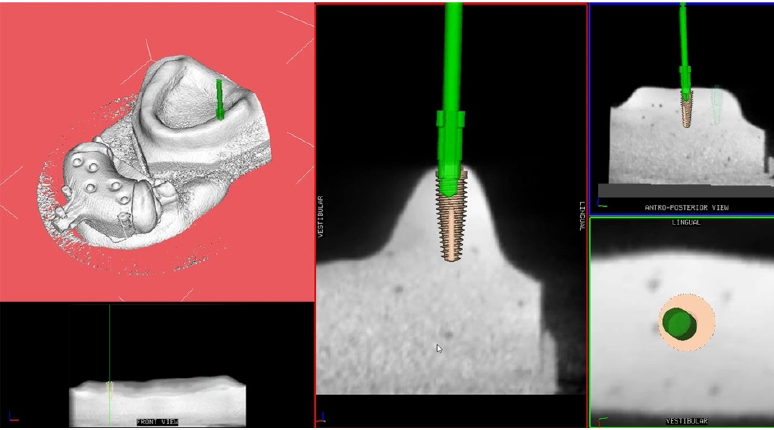
Figure 3. Screen display of the navigation system during implant site preparation.